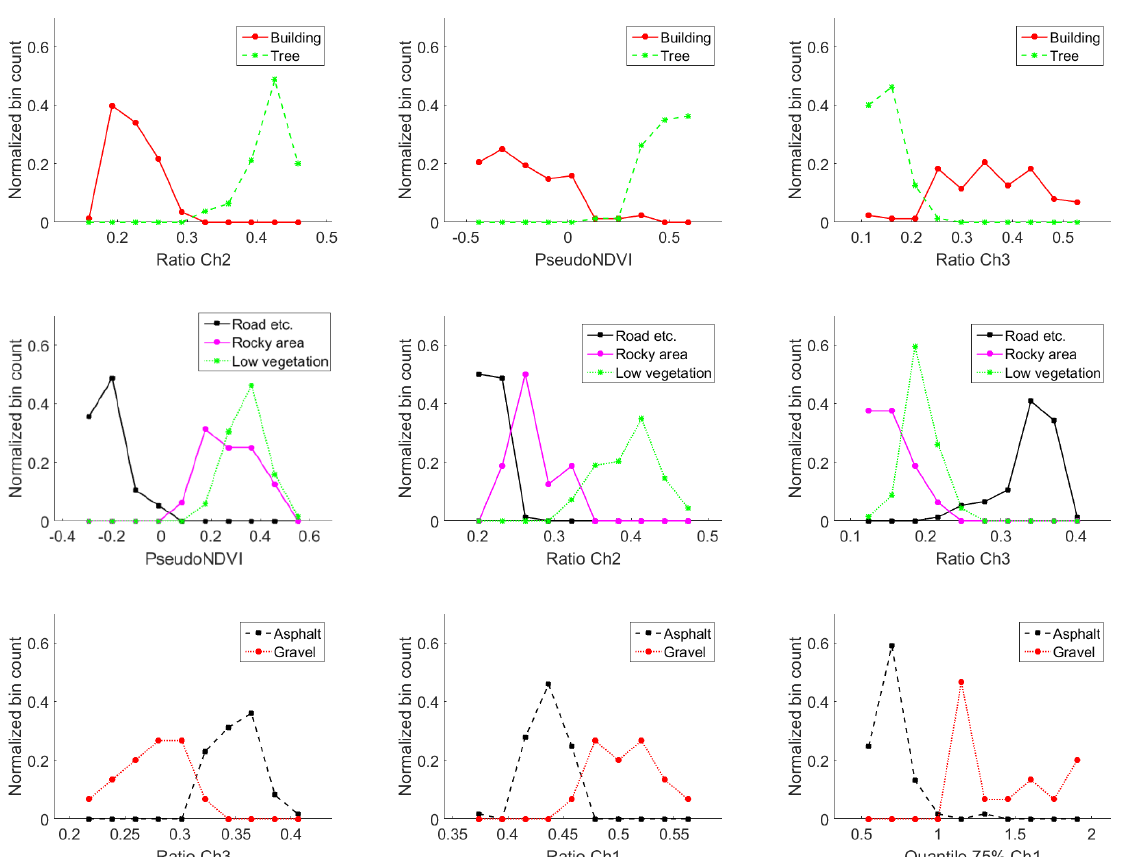
Figure 4. Histograms of training segments in different classes. Top: buildings and trees. Middle: roads etc. (class includes asphalt and gravel), rocky areas, and low vegetation. Bottom: asphalt and gravel. For each case, the three most important intensity features according to the feature importance analysis (Table 2, Figure 3) are